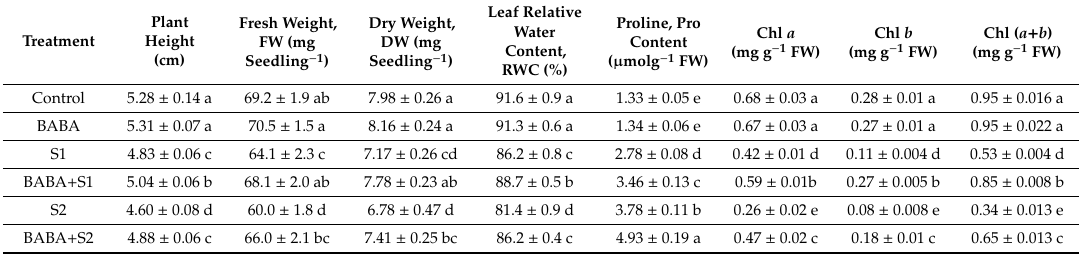
Table 2. E ff ect of BABA on plant height, fresh weight (FW), dry weight (DW), leaf relative water content (RWC), Pro content, chl a , chl b and chl ( a + b ) content of rapeseed ( Brassica napus L.) seedlings exposed to di ff erent concentrations of salt stress. Average from three replications (n = 3) was used to determine mean ( ± SD) for each treatment, and means of the same column were compared by letters where letters with di ff erent values varied significantly at p ≤ 0.05 due to Fisher’s LSD test.